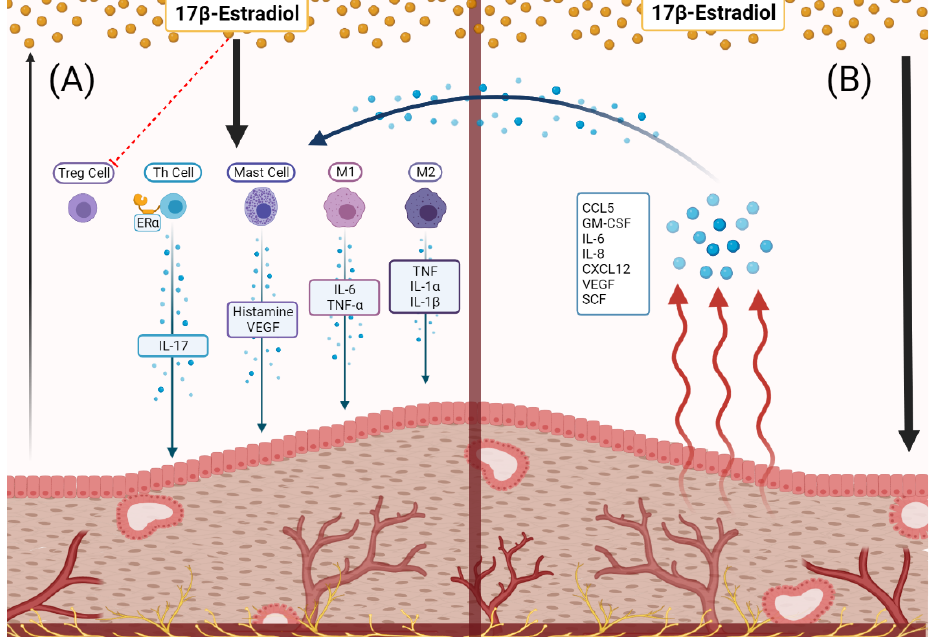
Figure 1. The immune-endocrine relationships of the endometriotic lesion. (A) Estradiol is sourced from systemic circulation and, to a small extent, the lesion tissue itself. Estradiol acts on immune cells to secrete inflammatory, angiogenic, chemokinetic molecules which contribute to lesion growth and disease progression; (B) estradiol causes the endometriotic lesion to produce immune signaling molecules [CCL5, GM-CSF, IL-6, IL-8, CXCL12, VEGF, stem cell factor (SCF)], subsequently acting on